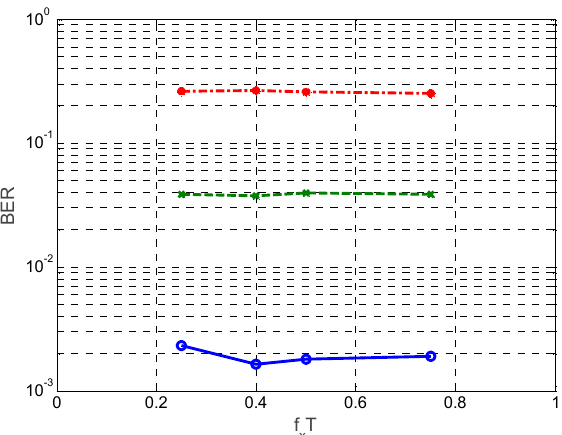
Figure 7. BER performance under different values of F D T and f x T when T = 10 -5 .